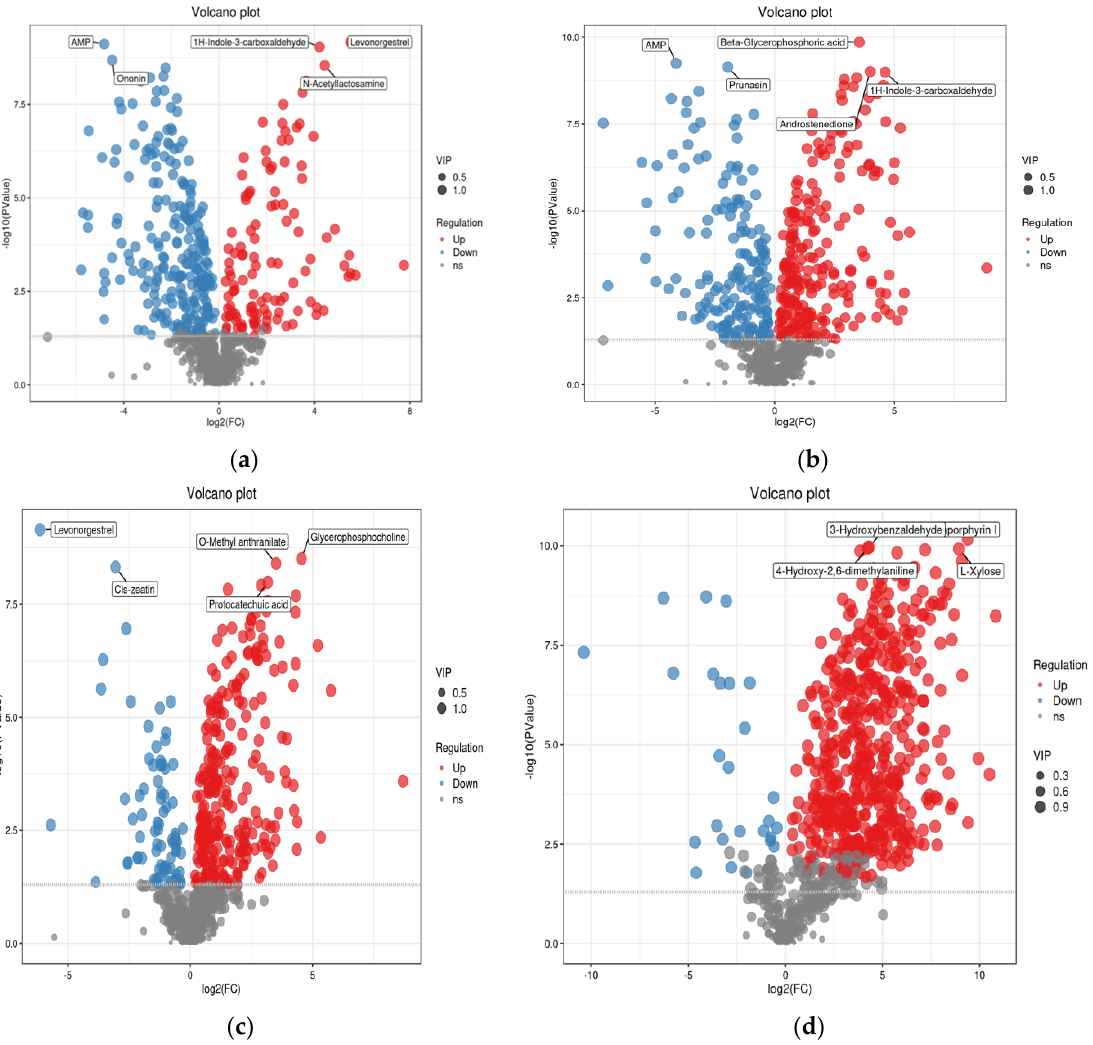
Figure 4. Volcano plots of differential compounds from four groups. The red dots indicate significantly upregulated compounds, and the blue dots represent significantly downregulated compounds. ( a ) Group #2 vs. group #3; ( b ) group #2 vs. group #4; ( c ) group #3 vs. group #4; ( d ) group #1 vs. group #4.